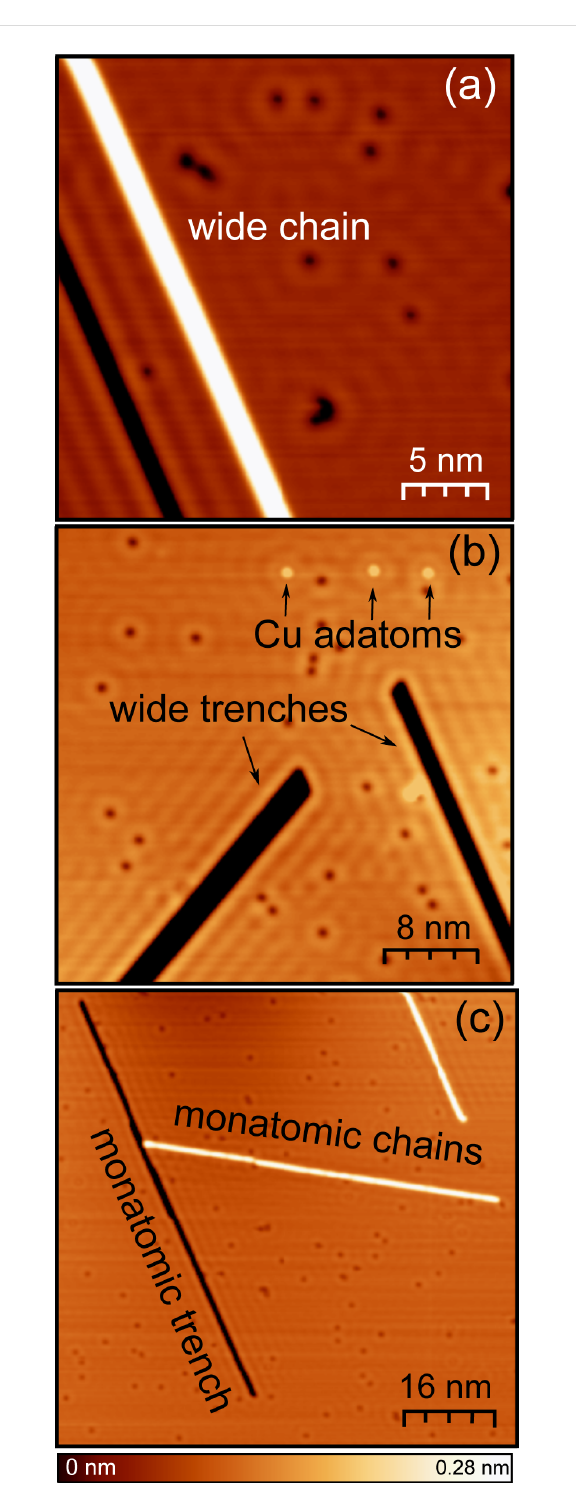
Figure 1: STM images of a Cu(111) surface with chains and trenches of monolayer height. (a) A Cu chain approximately two atoms wide and a parallel trench. (b) Two wide trenches (approx. 2 and 3 atoms) with deposited single Cu atoms. (c) Monatomic chains and trenches. The images were acquired at (a) V = 20 mV and I = 3 nA and (b, c) V = 100 mV and I = 5